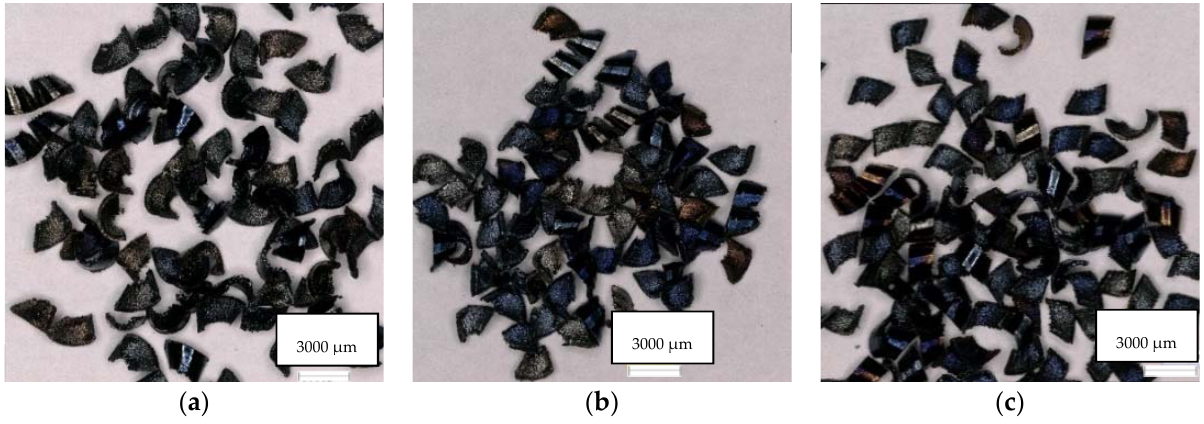
Figure 5. Chips after 30 min of machining of CMnCr steel ingots: ( a ) Bi-free, chips are satisfactory; ( b ) 0.08% Bi, chips are satisfactory; ( c ) 0.12% Bi, chips are satisfactory.